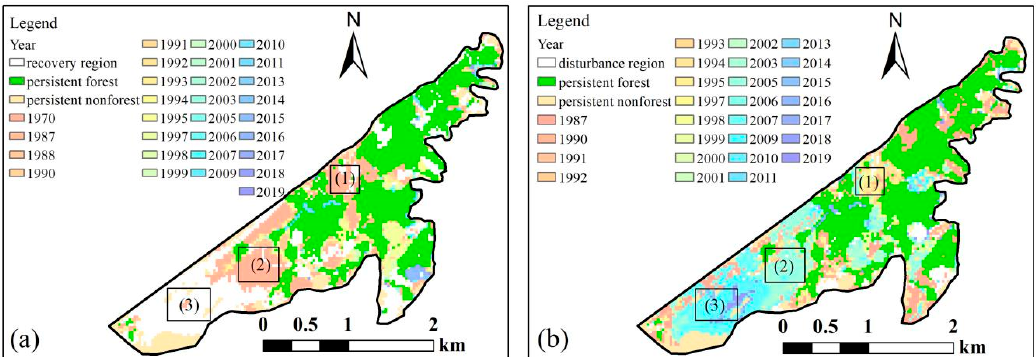
Figure 7. Forest loss and recovery maps: ( a ) first forest loss and ( b ) first forest recovery; (1), (2) and (3) indicate the former mining regions.